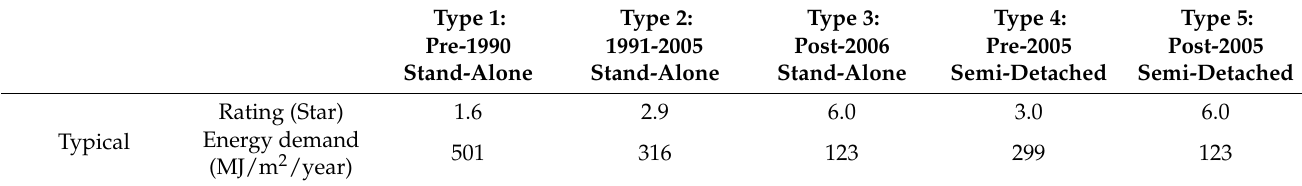
Table 6. Prototype energy efficiency star rating and applied upgrade